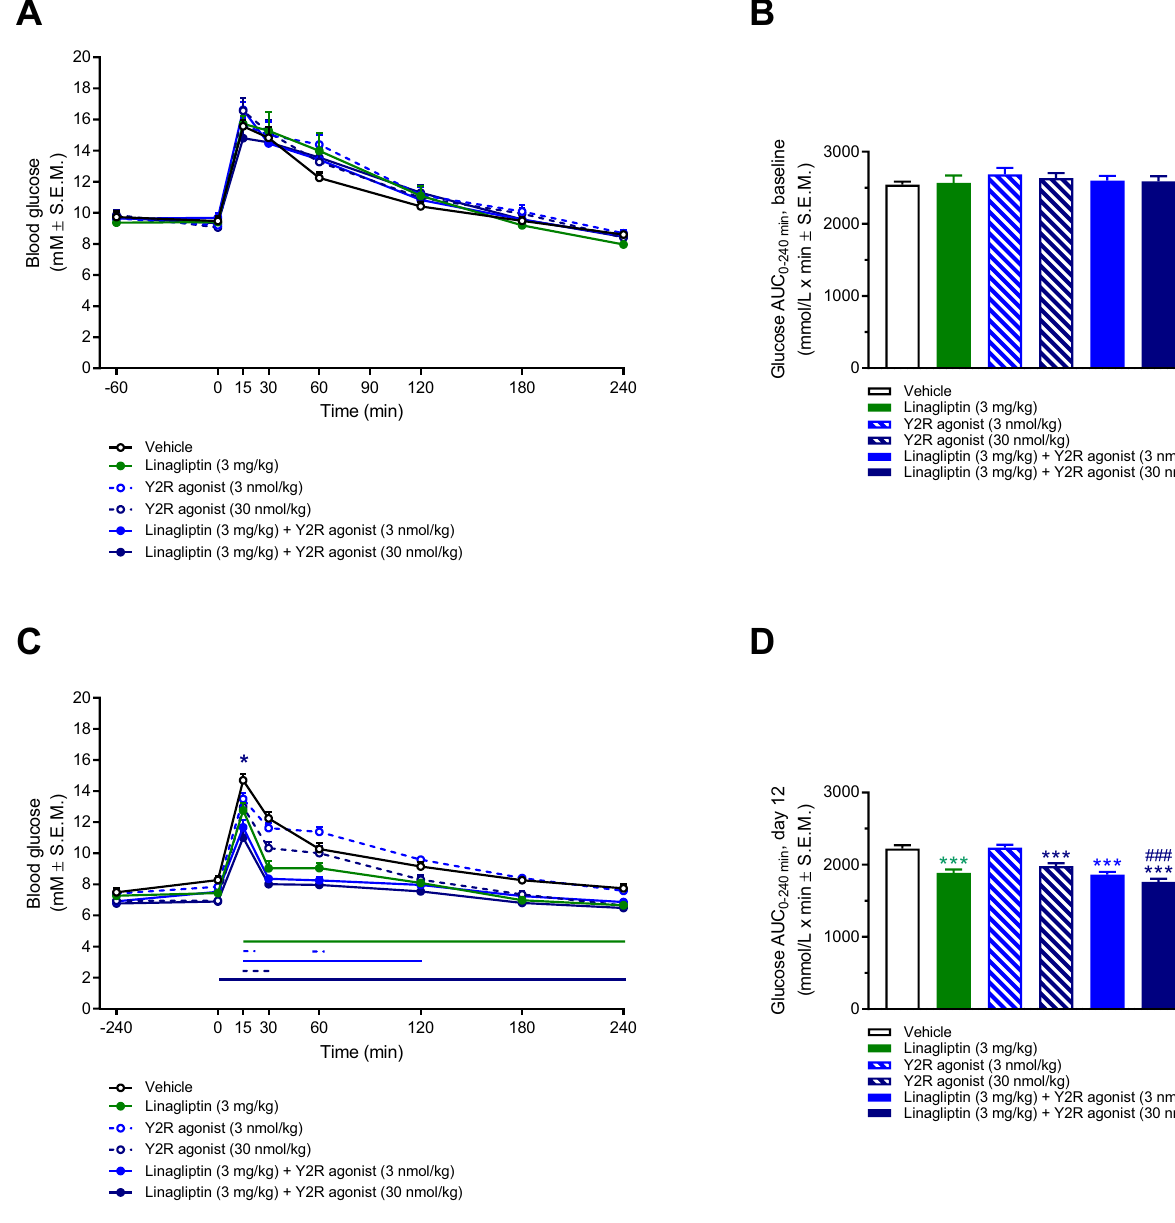
Figure 5. No synergistic effects of linagliptin and Y2 receptor agonist treatment on oral glucose tolerance in DIO mice. An oral glucose tolerance test (OGTT) was performed one week before treatment start (day − 7, A,B ) and on treatment day 12 ( C,D ). Horizontal lines denote significant change in blood glucose concentrations compared to vehicle control (p < 0.05, two-way ANOVA with Dunnett’s post-hoc test). *p < 0.05, linagliptin (3 mg/kg) + Y2R agonist (30 nmol/kg) vs. linagliptin (3 mg/kg), two-way ANOVA with Dunnett’s post-hoc